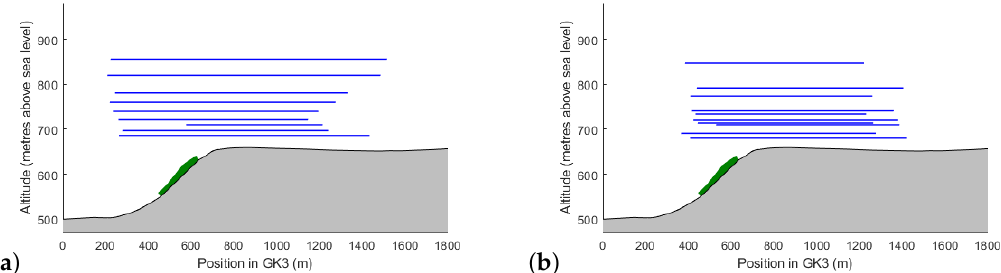
Figure 7. Visualisation of the modelled ground. The blue lines correspond to the legs performed by the MASC on 21 ( a ) and 22 ( b ) September. The green block represents the modelled